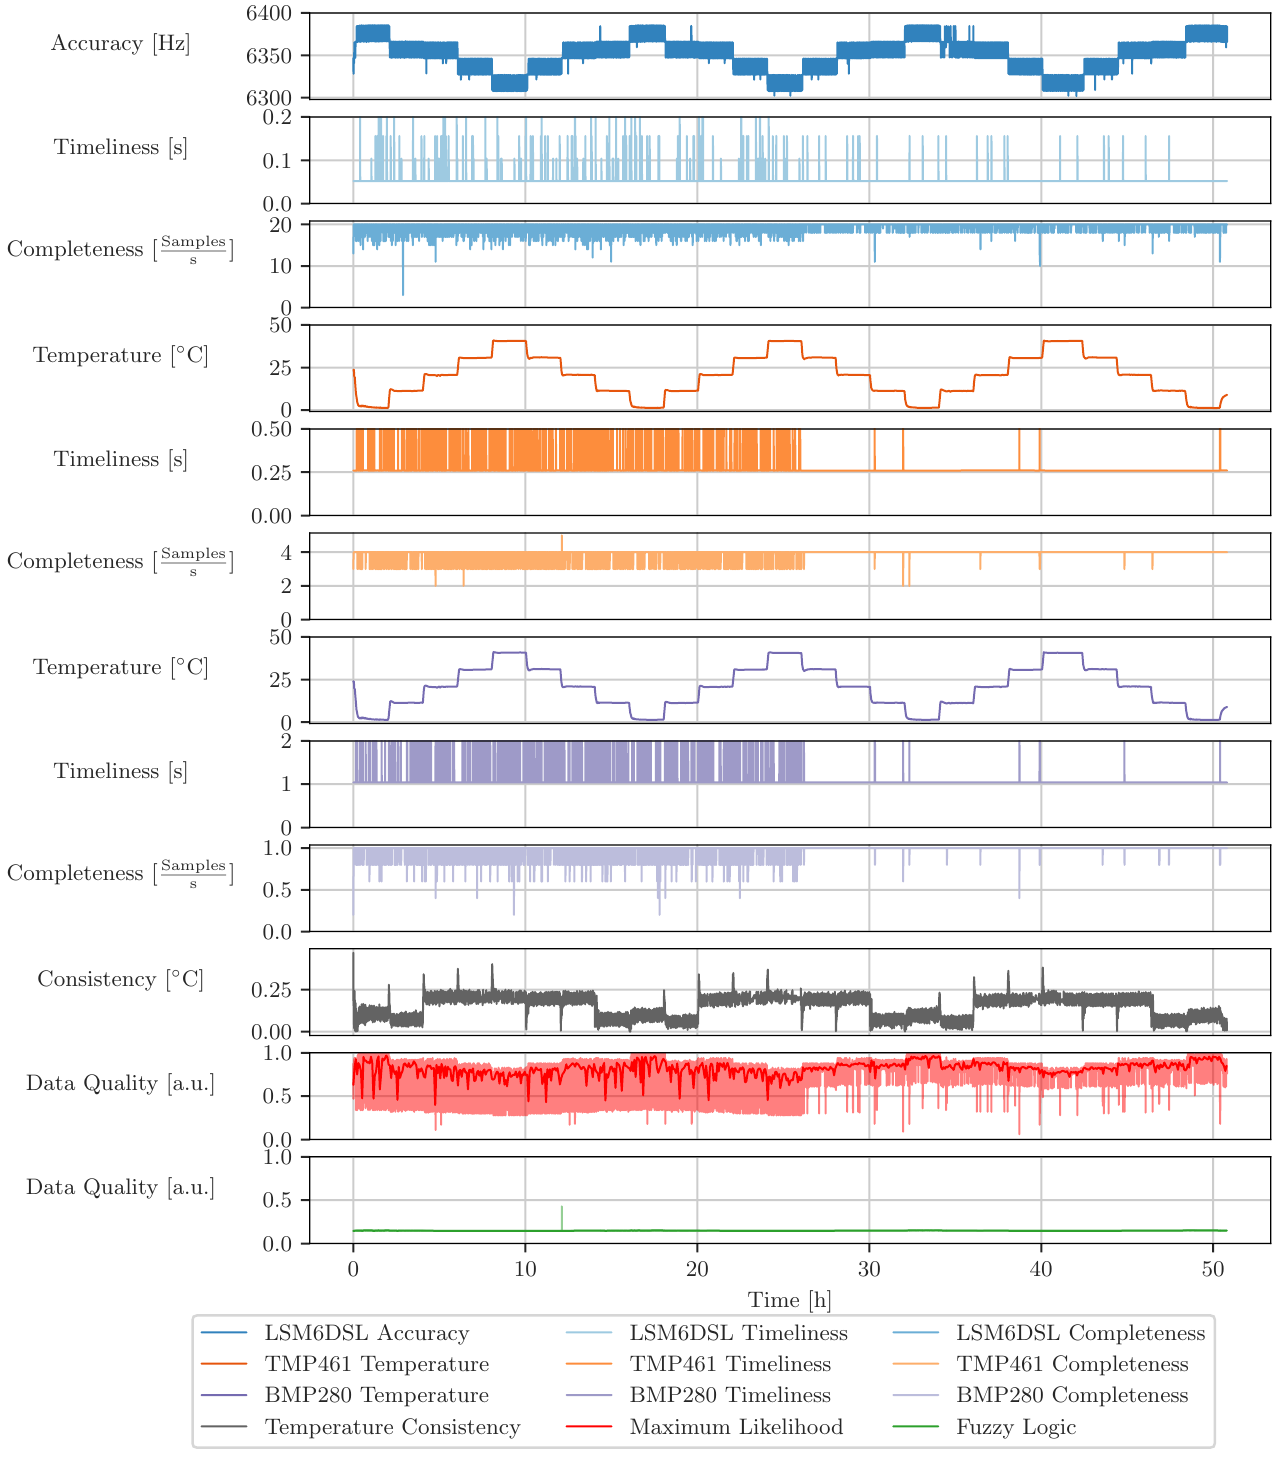
Figure A1. Accelerometer Data Set, sensor system 1, data quality attributes, measured values, and data quality